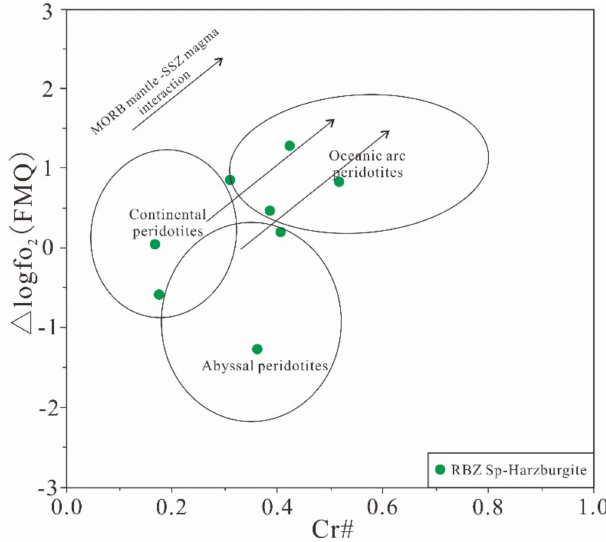
Figure 11. Diagram of Cr# and logfO2 (FMQ) of the spinel harzburgite from Raobazhai [27]. For the oxygen fugacity calculation method refer to [62]. The fields of abyssal (mid-ocean ridge) peridotites, continental (orogenic) peridotites and oceanic arc peridotites are taken from